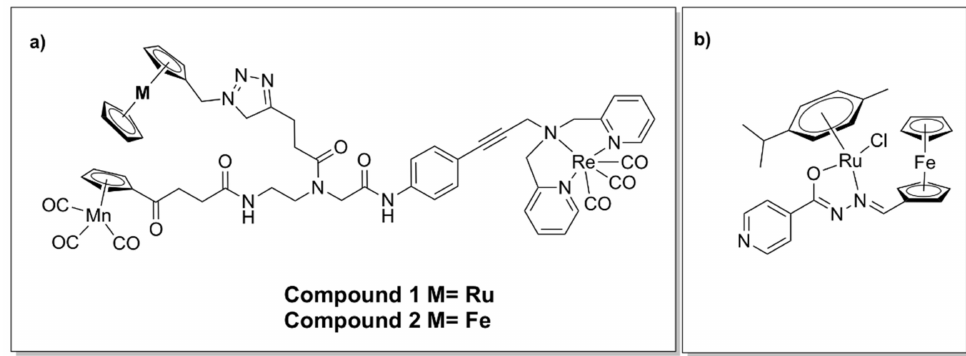
Figure 16. Chemical structures of hetero- ( a ) trimetallic complexes bearing ruthenocene or